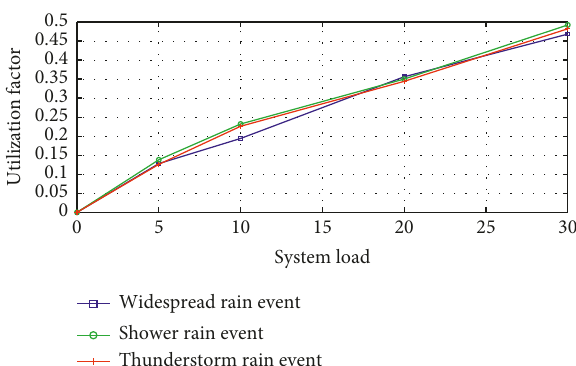
Figure 12: Utilization (one-period prediction).